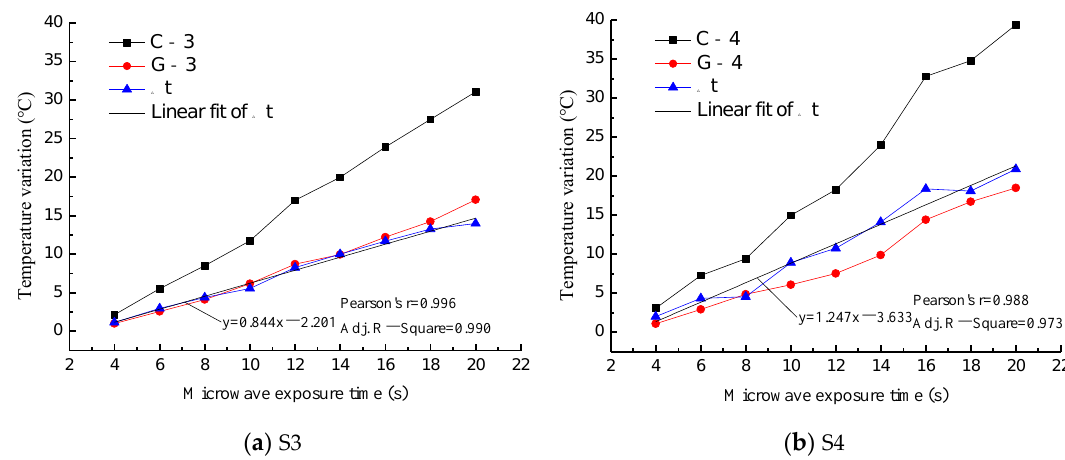
Figure 20. Results of coal and gangue microwave irradiation test under size S3 and S4.